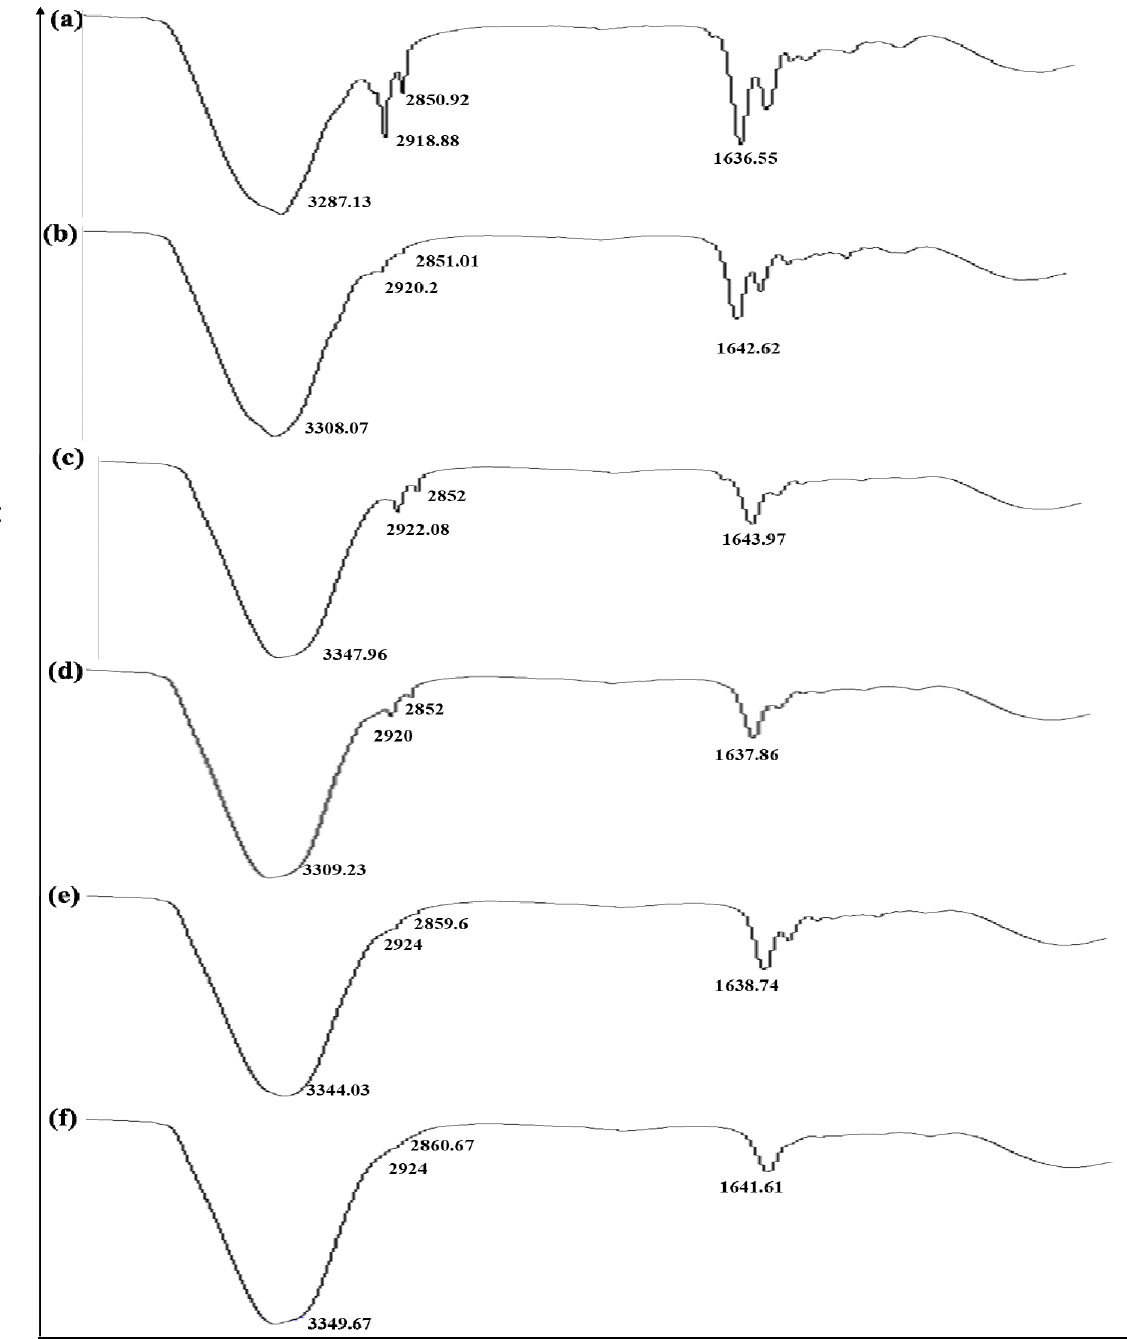
Figure 7. IR spectroscopy images of epidermis ( a ) untreated skin and skin treated with ( b ) SNE ( c ) MNE and dermis of ( d ) unloaded/blank skin and skin loaded with ( e ) SNE and ( f ) MNE.